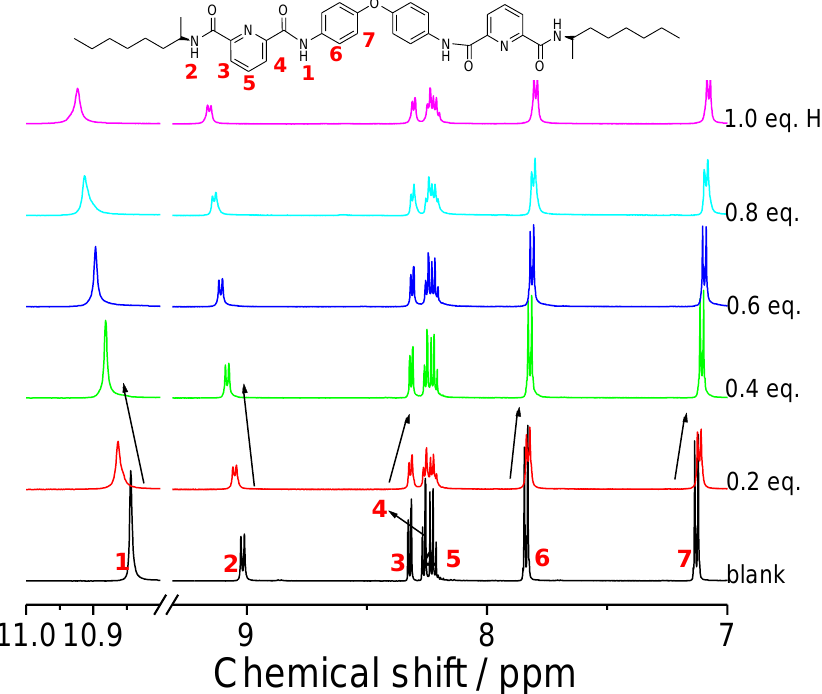
Figure 11. The partial 1 H NMR titration experiments of molecule 1 by Hg 2+ in DMSO-d 6 at 298 K. The concentration of gelator 1 was 11.6 mM.